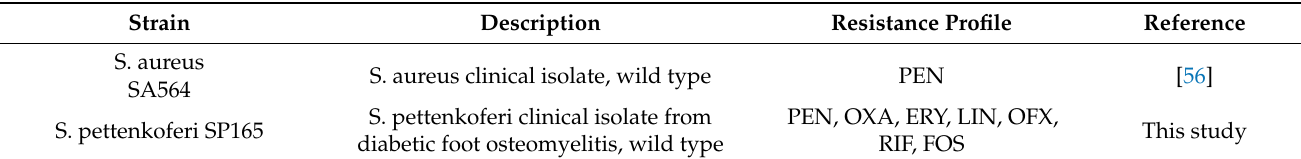
Table 2. Strains used in this